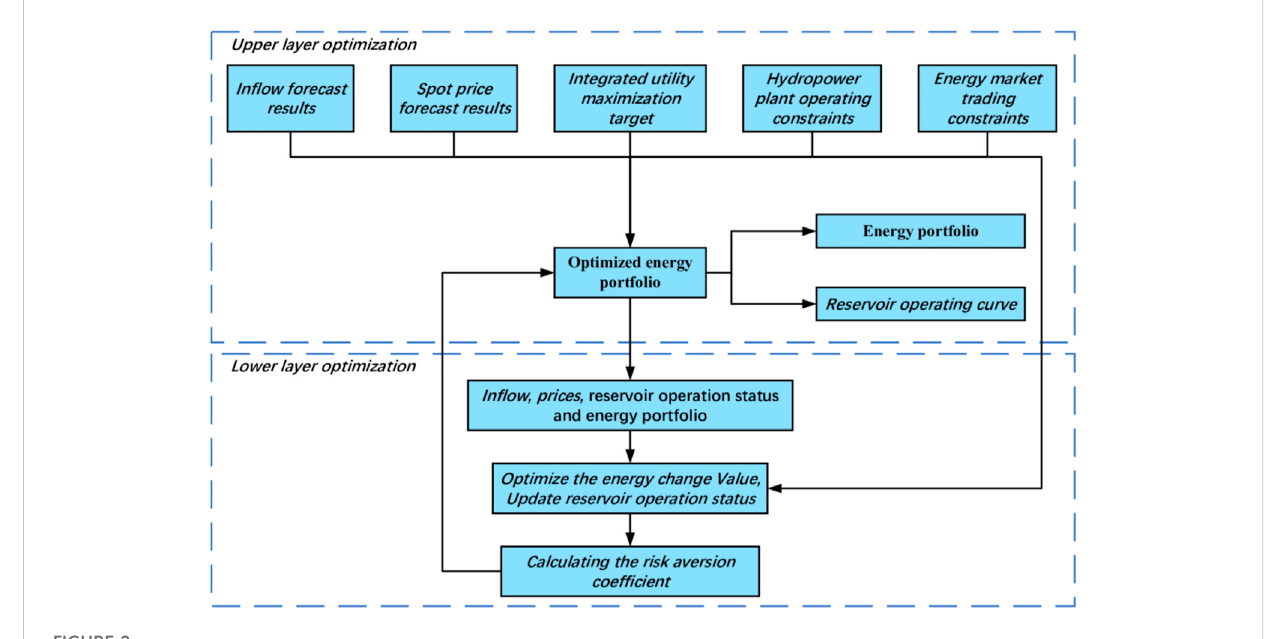
FIGURE 2 Double-layer optimization